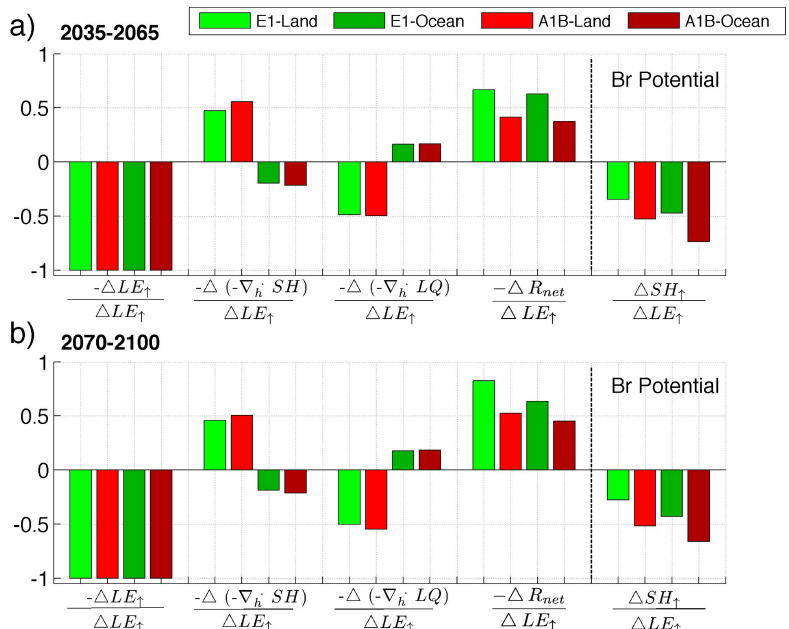
Fig. 10. Land averaged (light colors) and sea averaged (dark colors) contributions to the ratio between surface sensible and latent flux changes (Potential Bowen ratio; PBr), compared to the reference 1970–2000 climatology for (a) 2035–2065 and (b) 2070–2100 averages. Contributions from the atmospheric convergence of sensible heat ( −∇ h · SH) and latent heat ( −∇ h · LQ), radiation absorption ( R net ) and surface latent heat (LE ↑ ) are reported for A1B (red) and E1 (green).